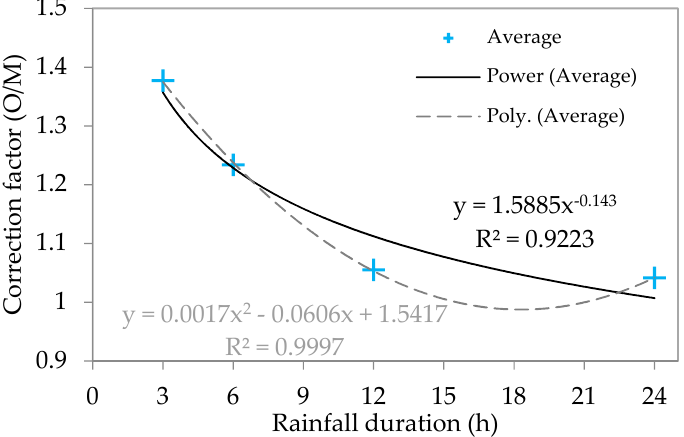
Figure 7. Correction factor for modelled rainfall intensities fitted into higher order equations.